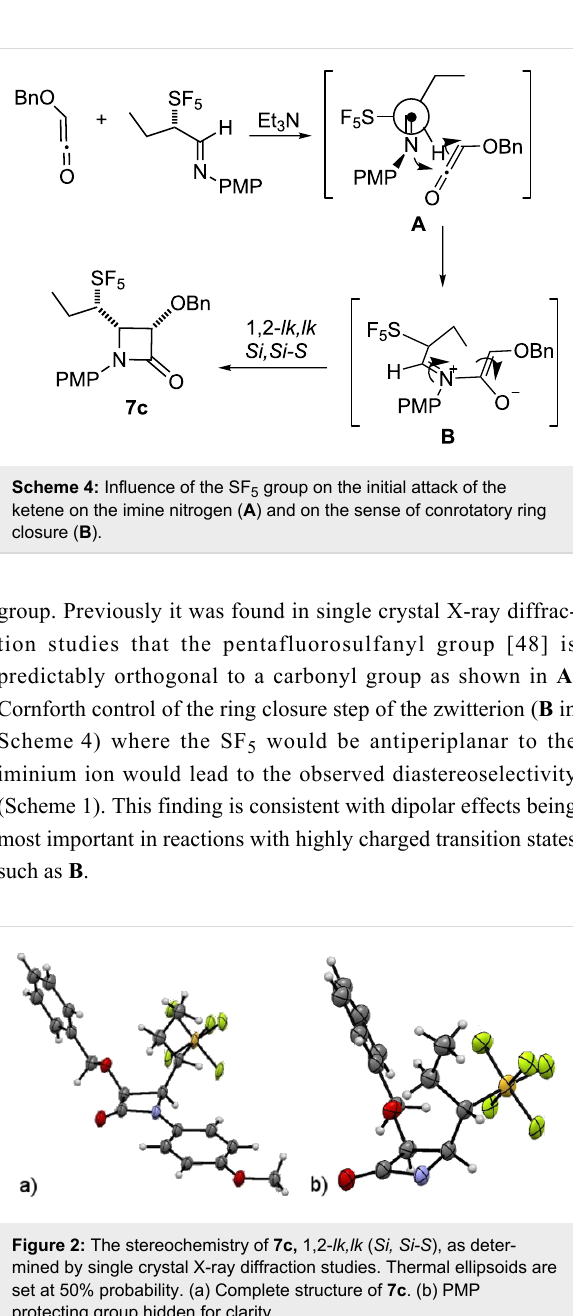
The ketene–imine condensation of 7c is influenced by the pres- ence of the pentafluorosulfanyl group at a stereogenic center.